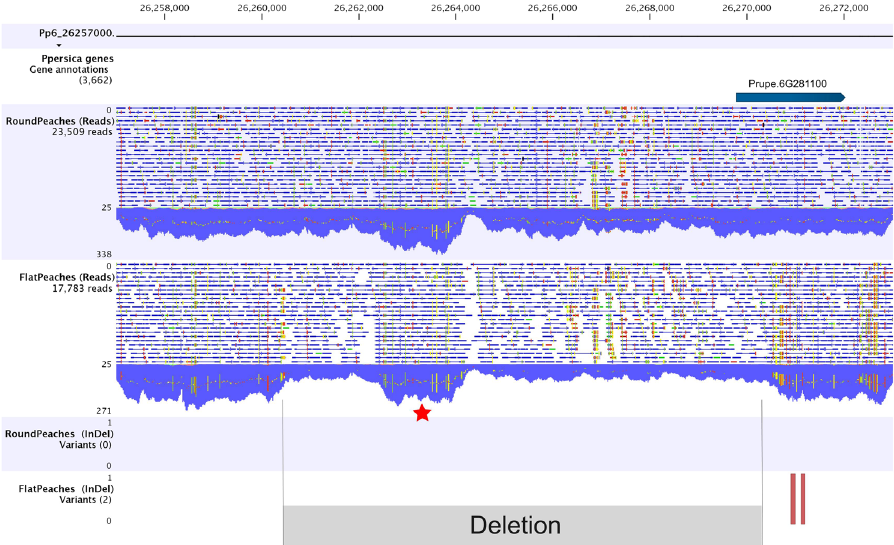
Figure 3. Alignment of round and flat peaches reads against Pp06:26,262,400.26,264,250 region. CLC- Workbench track display including (a) Pp06:26262400.26264250 region Prupe.6G281100, (b) bulked alignment of Illumina reads from five round and (c) five flat peaches. Blue areas represent the sequence depth at each position. The reduction in the number of reads in the flat peaches reveals the deletion in heterozygosis. An increase in the number of reads in the region Pp06:26,262,400.26,264,250 (labeled in the figure with a * ) is produced by the spurious alignment (confirmed by Sanger sequencing) of a highly repetitive region. (d) The CLC- InDels and structural variants tool identified the two indels in the flat varieties